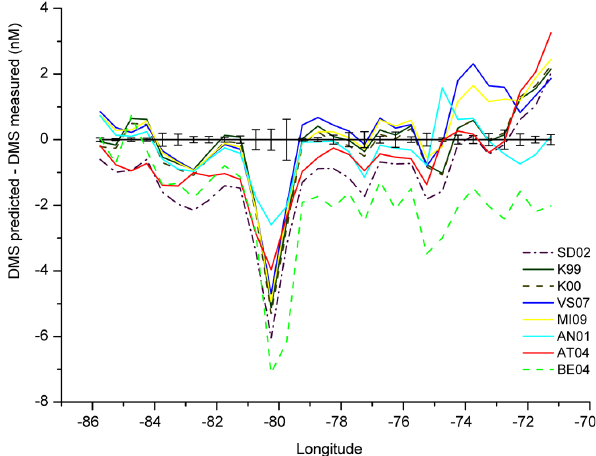
Fig. 5. The difference between predicted DMS and measured DMS concentrations plotted against longitude for the VOCALS REx cruise in the SE Pacific. The measured DMS is plotted as 0 and the error bars represent 1 standard error. For each predicted DMS dataset, the optimum parameters were chosen as determined using the overall ranking system shown in Table 5.3. The data are in 0.5 ◦ longitude bins. The algorithm acronyms are explained in the